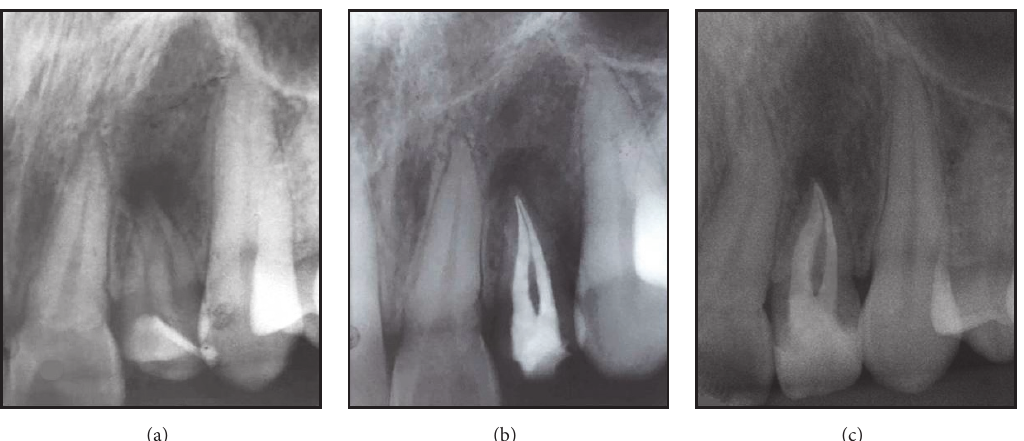
Figure 2: Operative imaging sequence. (a) Initial radiograph suggesting a geminated tooth; (b) final radiograph; (c) follow-up over 6 months’ radiograph.